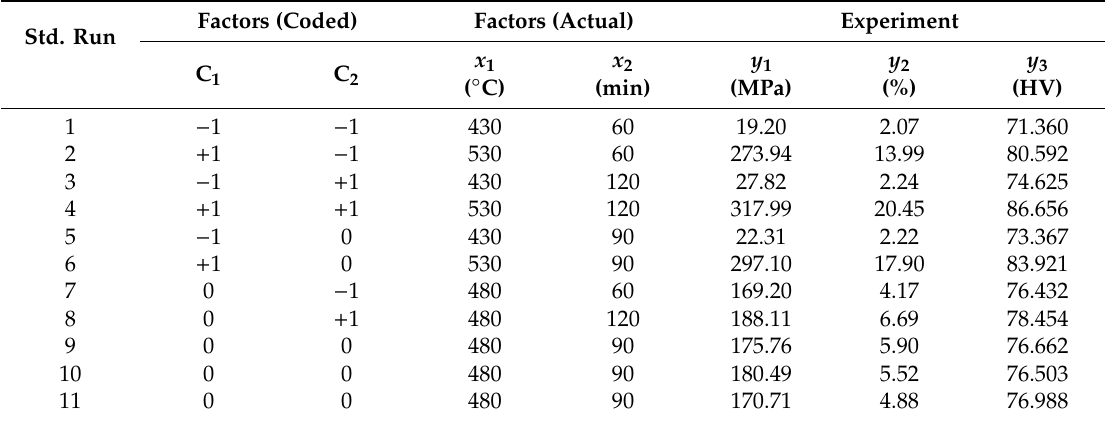
Table 3. Completed design